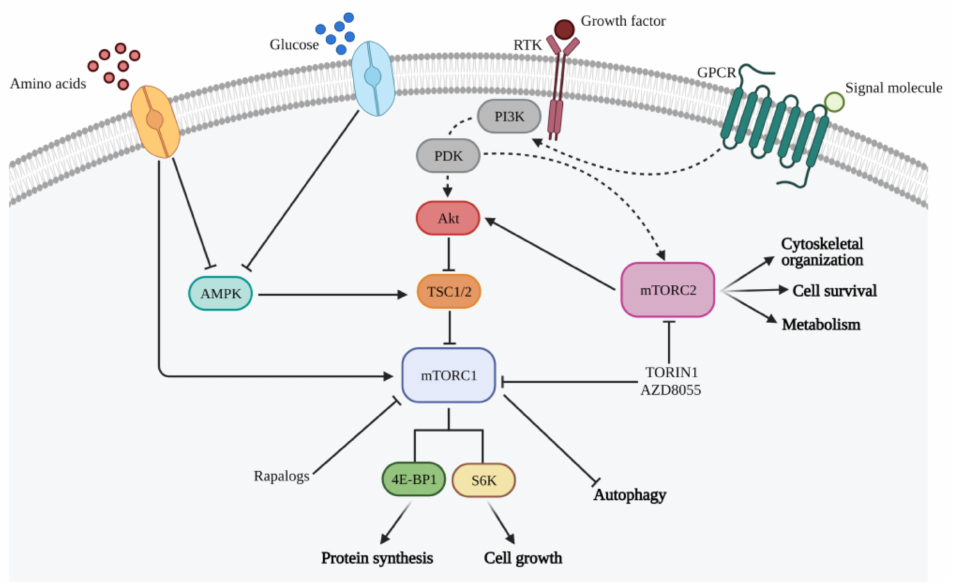
Figure 1. Representative image of the main signaling pathways that regulate mTOR. mTORC1 is able to capture and transduce signals from different stimuli, such as the presence of growth factors, amino acids, and glucose through the mechanisms indicated. Once activated, mTORC1 promotes cell growth and proliferation, inducing various anabolic processes, including protein synthesis, and inhibiting catabolic processes, such as autophagy. mTORC2, on the other hand, performs an important regulatory function of the cytoskeleton, cell survival, and metabolism and phosphorylates the Akt kinase, determining its activation. This image was created with BioRender